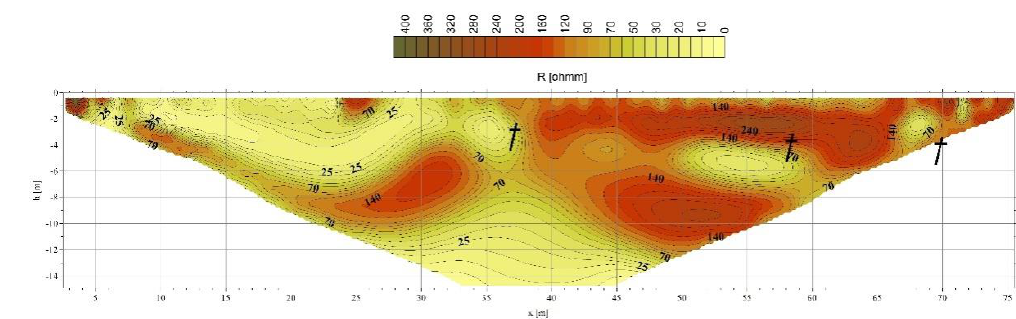
Figure 17. Charles Square. The resistivity cross-section (ERT) with indications of the graves (see small